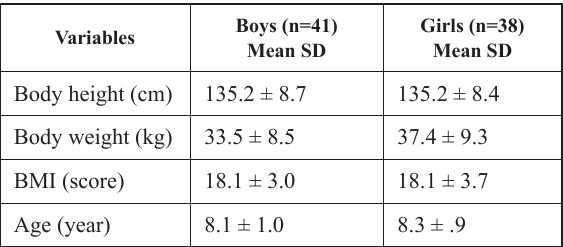
Table 1. Sample characteristics in morphological